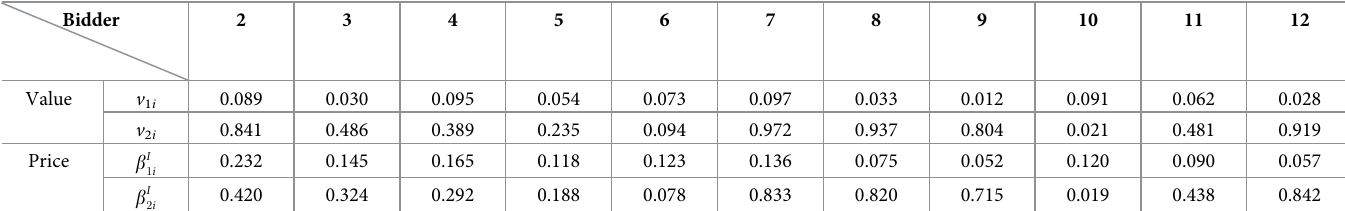
Table 5. Transaction bidding price of bidders for the first-price format.